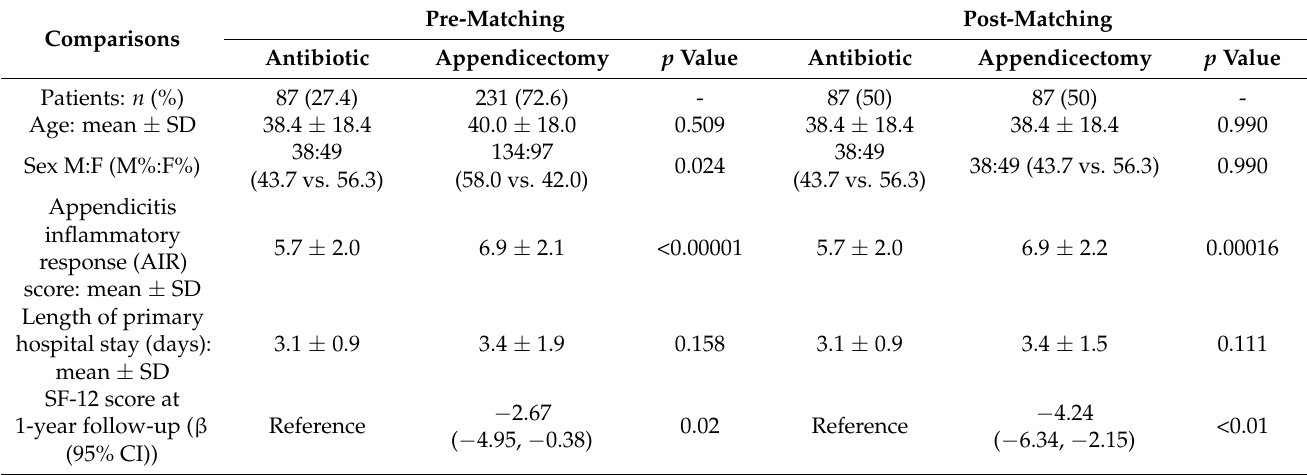
Table A2. Pre- and post-matching samples used for propensity score-matched analysis in the ACTUAA trial